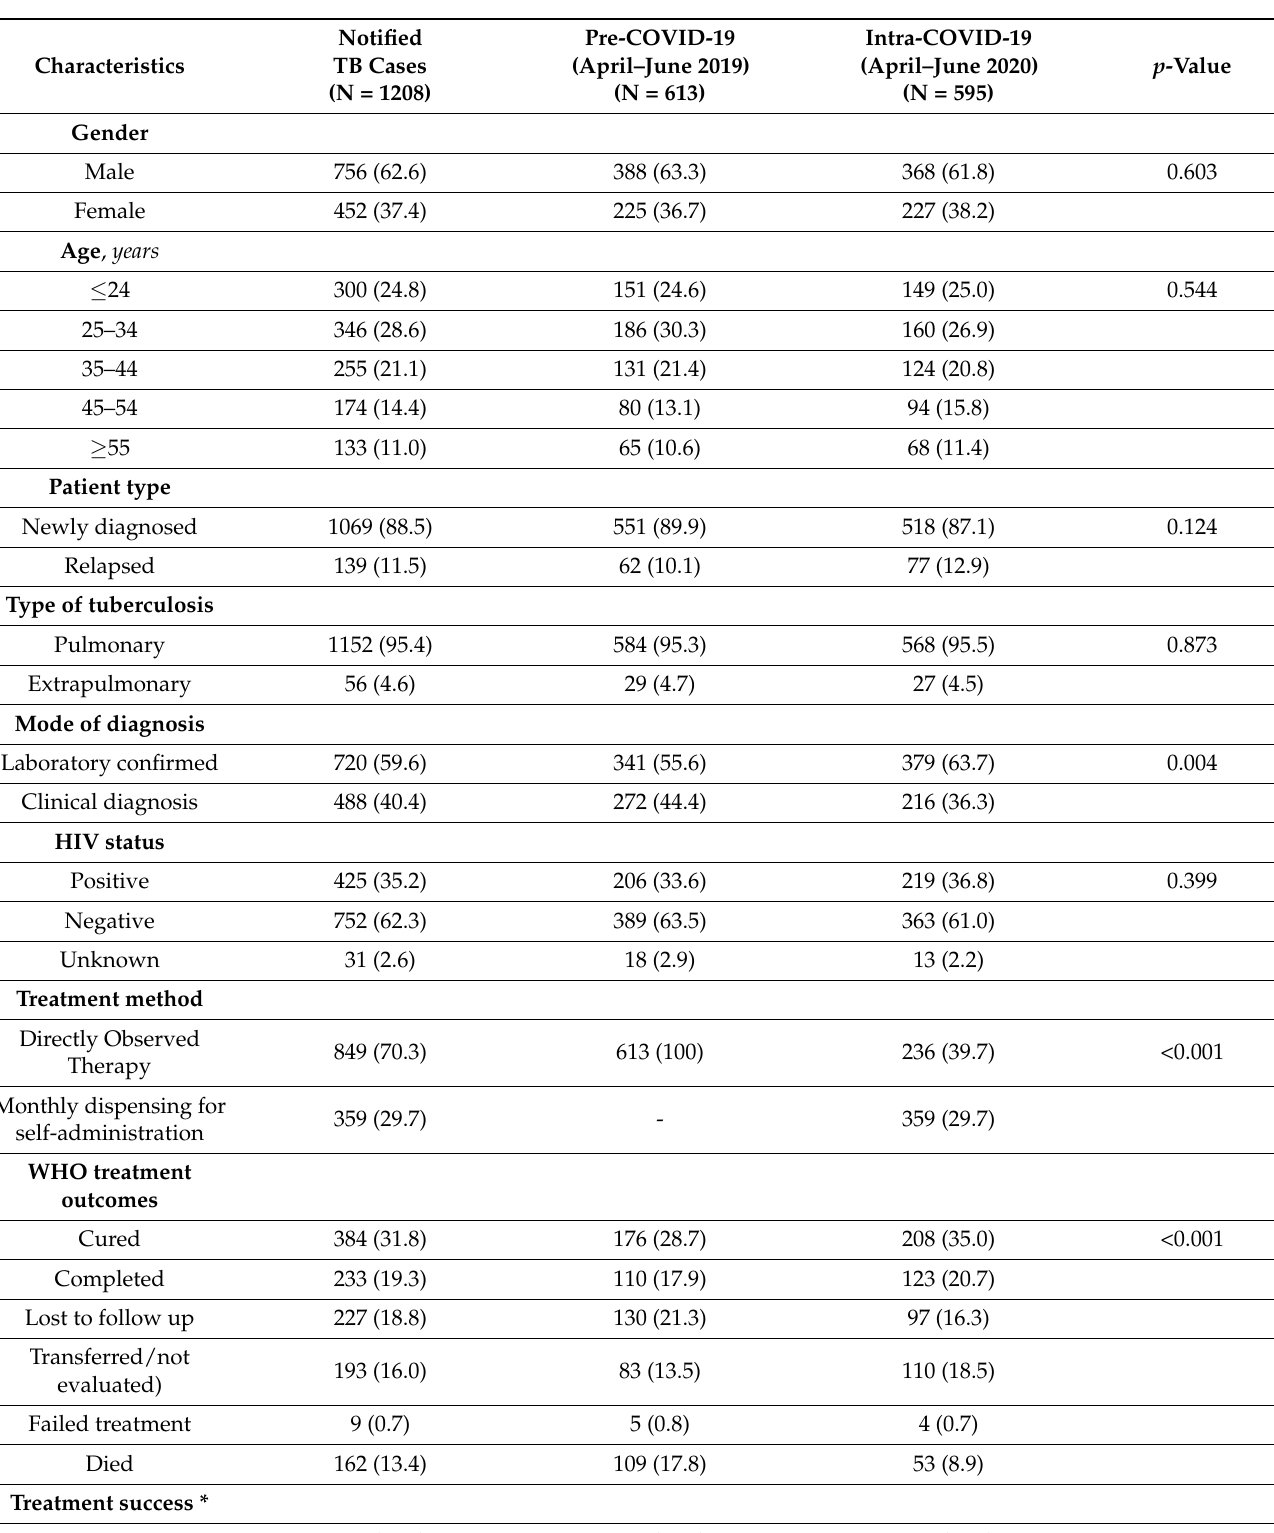
Table 2. Comparison of TB treatment outcomes during the pre- and intra-COVID-19